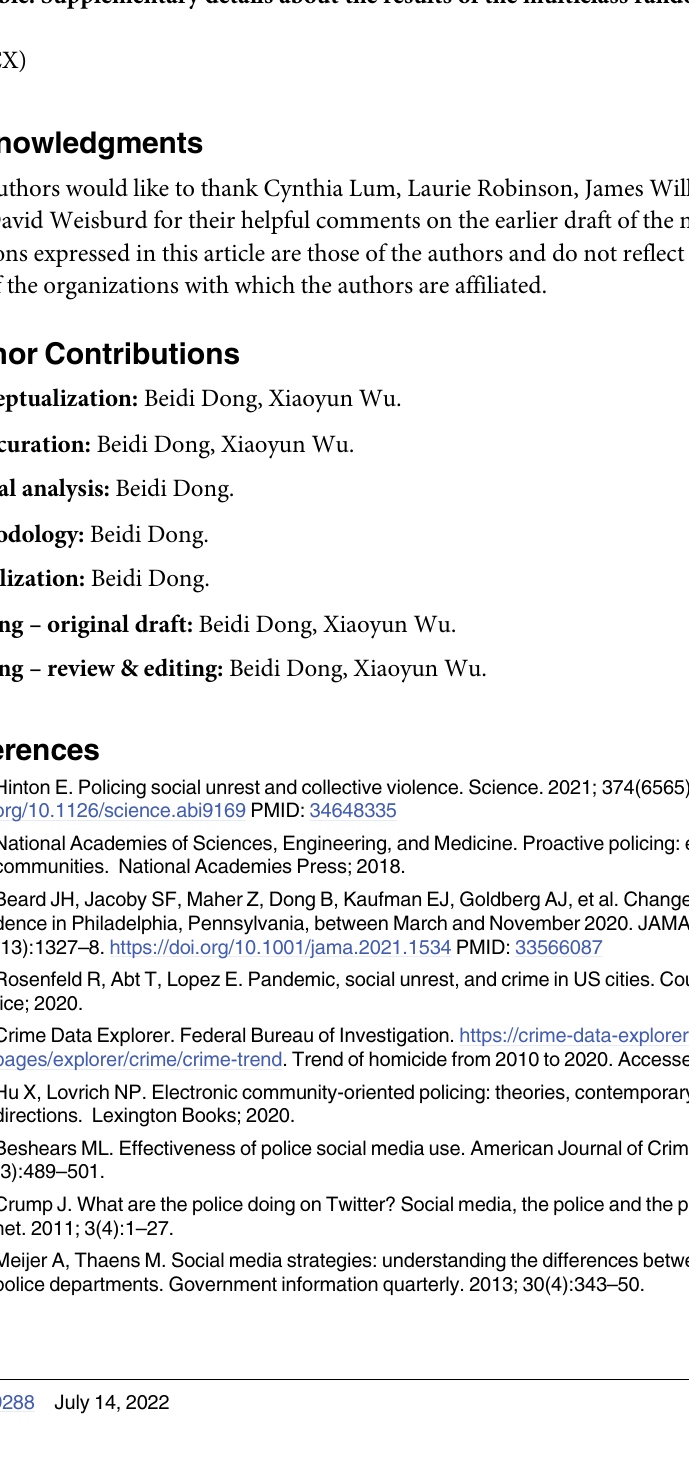
S2 Table. Detailed categorization scheme used in the study. S3 Table. Random forest and multiclass boosted trees classifier. S4 Table. Exemplary tweets illustrating sentence-level pleasant or attractive vs. unpleasant or aversive emotion. S5 Table. Supplementary details about the results of the multiclass random forest classi-